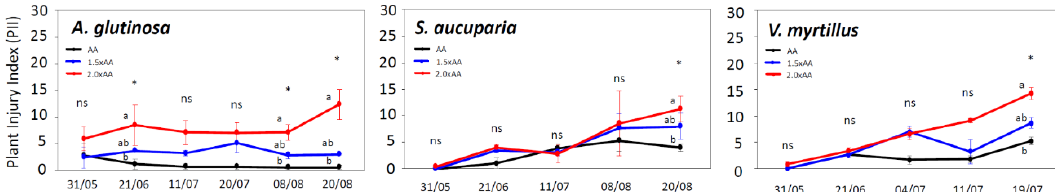
Figure 3. Plant injury index (PII) in Alnus glutinosa , Sorbus aucuparia, and Vaccinium myrtillus exposed to three levels of O 3 concentration (AA, ambient O 3 concentration 1.5 × AA, and ambient O 3 concentration 2.0 × AA). The points represent mean ± S.E. ( n = 3 plots). Asterisks show the significance of Kruskal–Wallis tests: * p < 0.05 and ns, not significant. Different letters show significant differences among treatments in each date ( p < 0.05, Mann–Whitney U test).